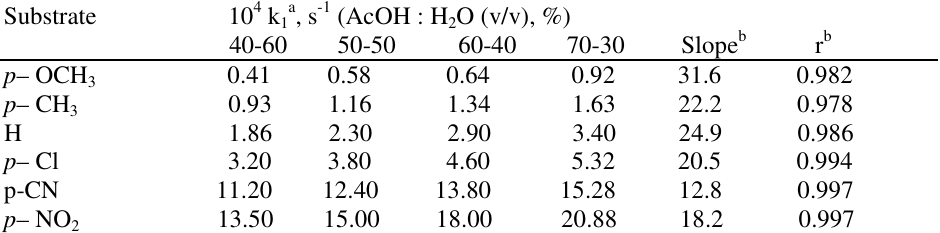
Effect of the solvent polarity on the rate of reaction at